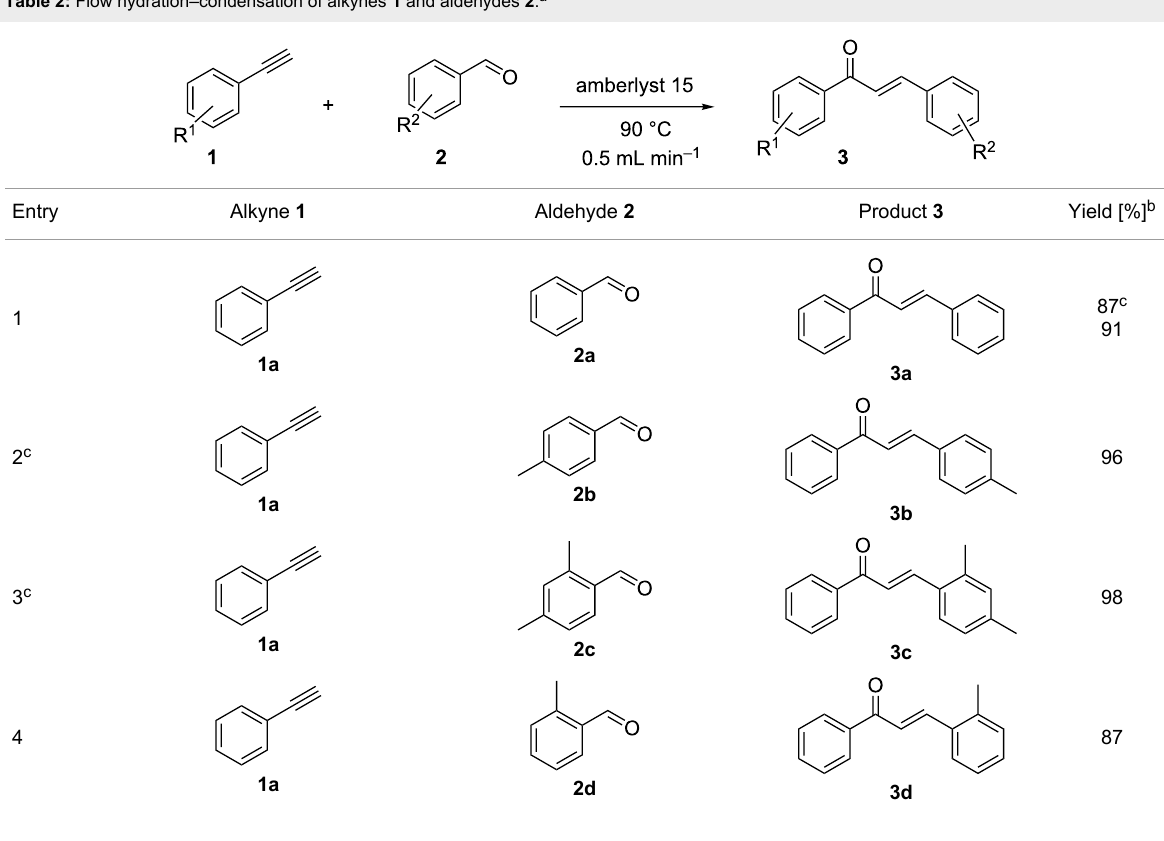
Table 2: Flow hydration–condensation of alkynes 1 and aldehydes 2 .